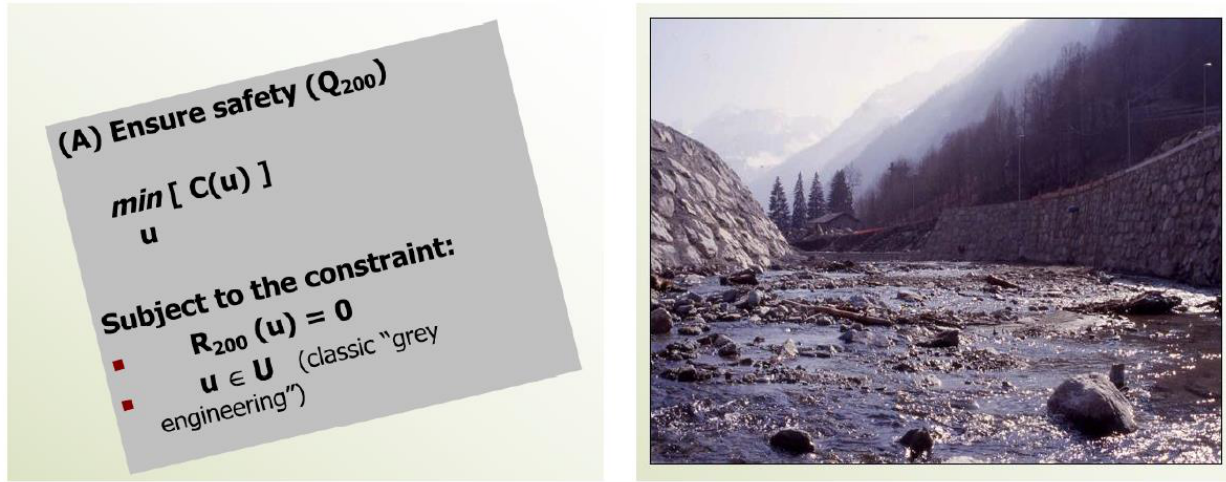
Figure 1. The classic hydraulic engineering paradigm: ( left ) schematic formulation; ( right ) an emblematic example of intervention (Photo by A. Goltara, T. Noce, Northern Italy). ensure that, given a reference event (e.g., a 200-year return period flowrate Q 200 ), the associated flood risk R 200 ( u ) is nullified (i.e., all lower events will produce no damages), while trying to spend an amount C( u ) as little as possible, and choosing interventions ( u ) mainly aiming at reducing the hazard (rather than the exposed value), from a set U of classical “grey” ones (levees, dikes, reservoirs, recalibration of river channels, dredging, by-passes,